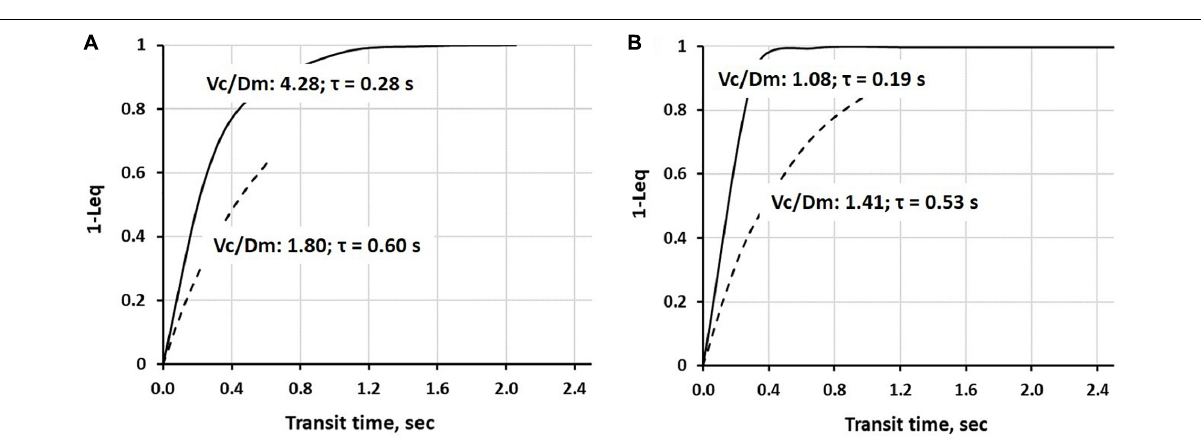
Frontiers in Physiology |